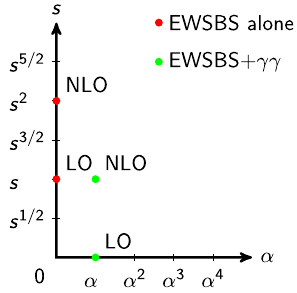
/( 4 πv) 2 as EM and s